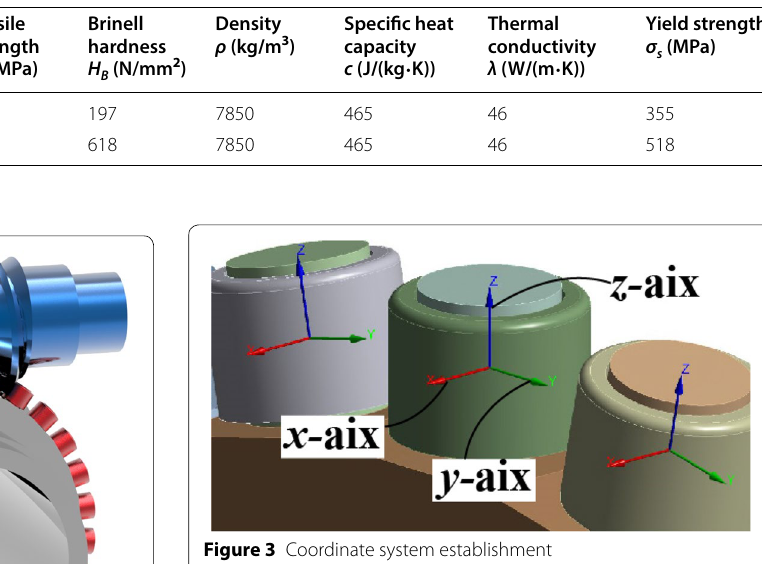
Figure 3 Coordinate system establishment